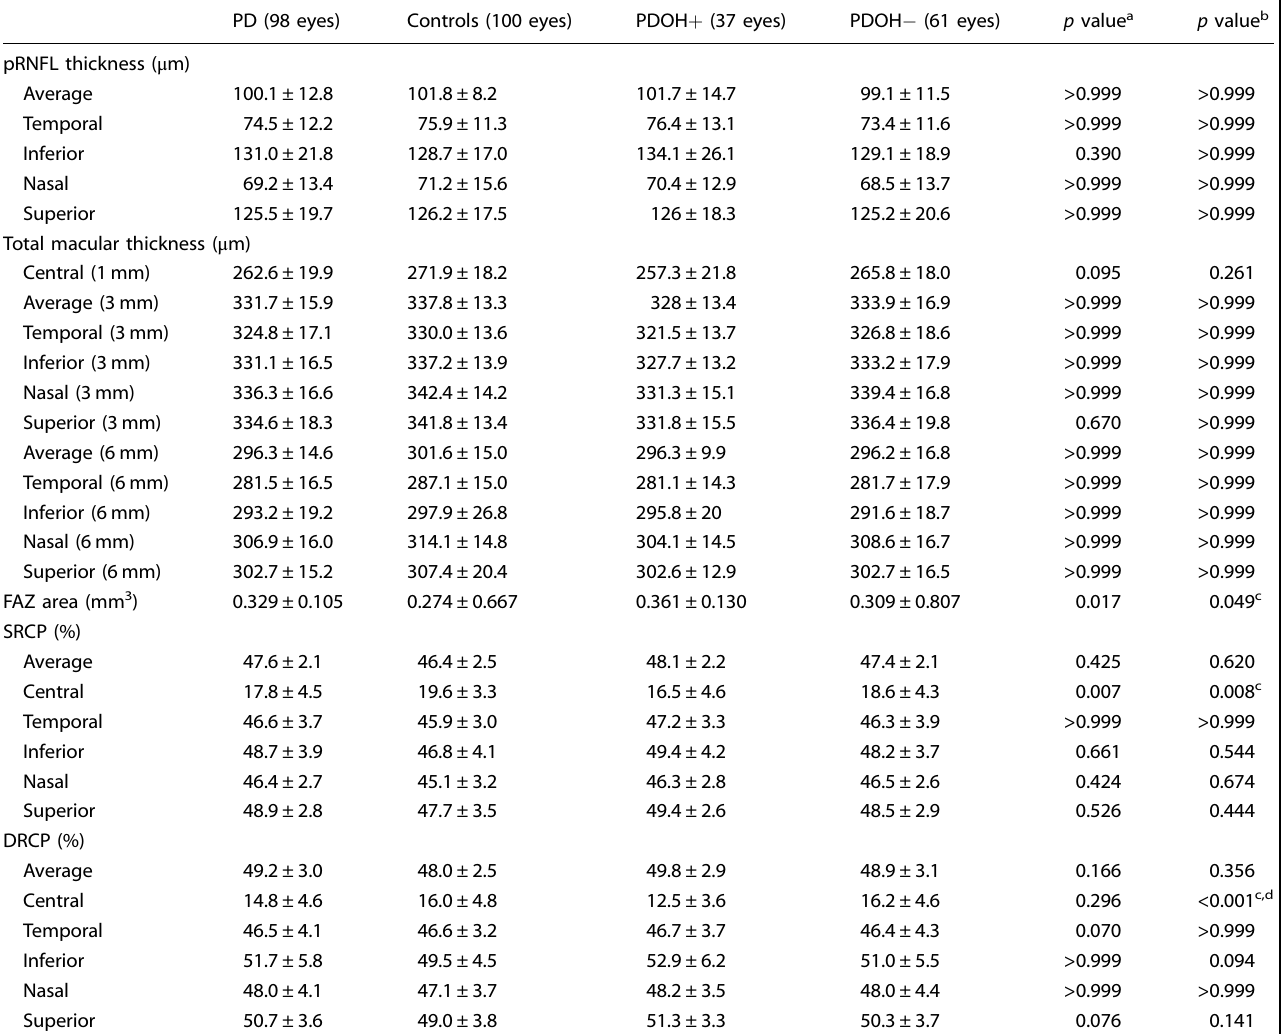
Table 2. Comparison of retinal layer thickness and parafoveal vessel densities in patients with Parkinson ’ s disease and healthy